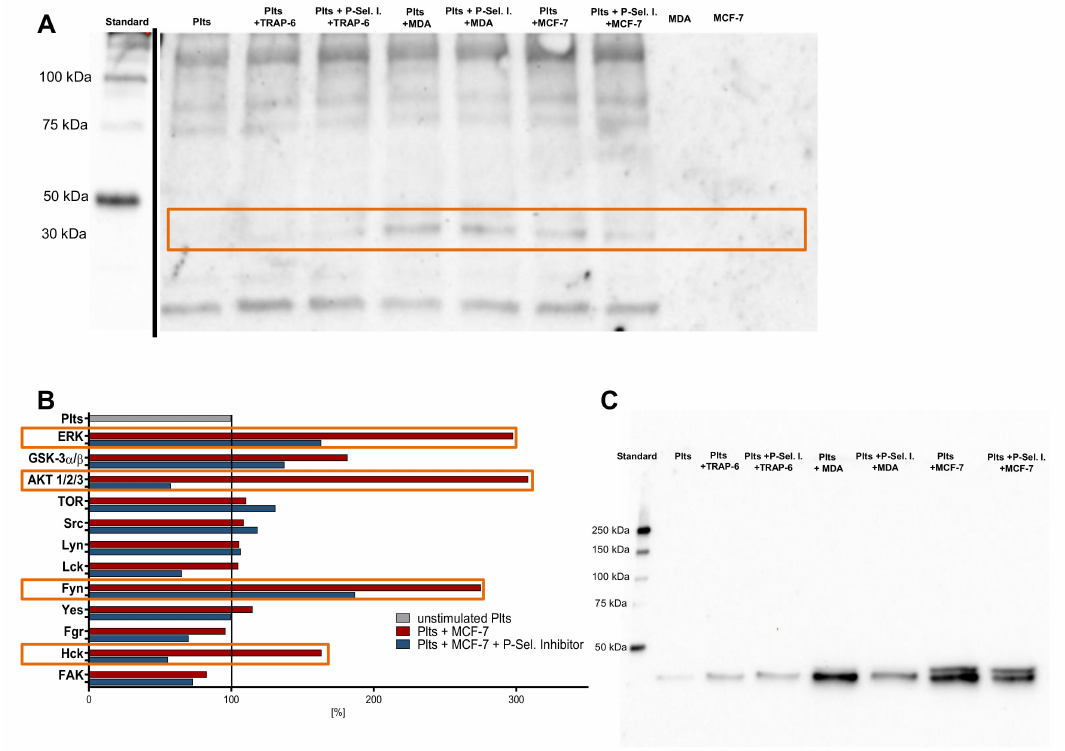
Figure 5. P-selectin mediated signaling in platelets. ( A ) Immunoblot analysis using an anti-phosphoserine / phosphothreonine / phosphotyrosine antibody of lysates from resting platelets, platelets after activation with 41 µ M TRAP-6, after co-incubation with MDA-MB-231 or MCF-7 cells (1 × 10 4 cells / mL), respectively. Platelets were preincubated with 100 µ g / mL P-selectin inhibitor for 30 min in some samples. Standard from the same gel at an earlier time was inserted in the figure to avoid overexposure. The orange box indicates changes in platelet phosphoproteome; ( B ) proteome profiler Phospho-Kinase array kit of lysates from platelets co-incubated with P-selectin inhibitor or without coincubation and stimulated with MCF-7 cells. Twelve kinases (as indicated in the figure) involved in platelet signaling were quantified simultaneously. The orange boxes indicate changes in phosphorylation of di ff erent kinases due to P-selectin inhibition; ( C ) immunoblot analysis of lysates using an anti-pERK1 / 2 antibody from resting platelets, platelets after activation with 41 µ M TRAP-6, after coincubation with MDA-MB-231, or MCF-7 cells (1 × 10 4 cells / mL), respectively. Platelets were preincubated with 100 µ g / mL P-selectin inhibitor in some